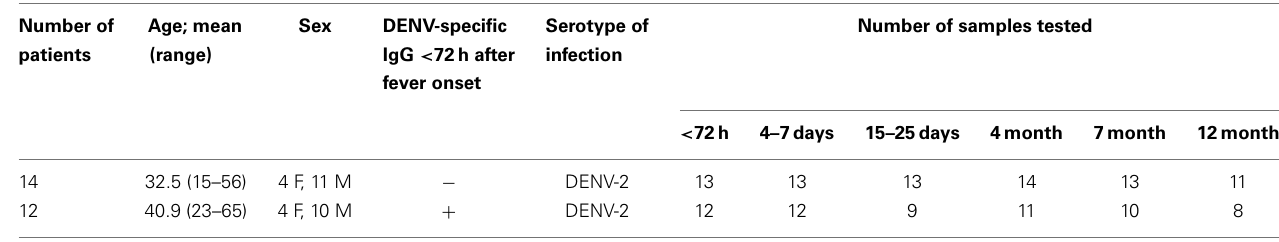
Table 1 | Cohort 1: longitudinal antibody analysis .